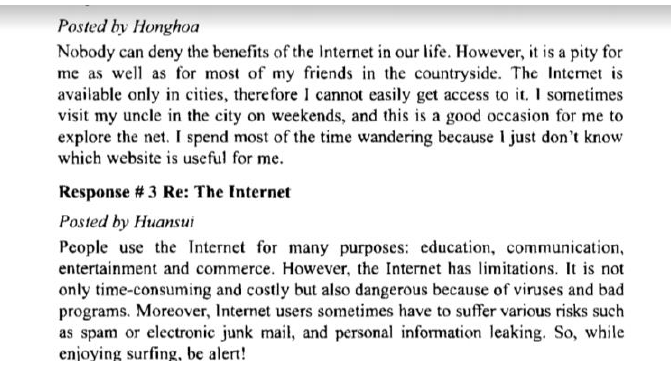
Figure 4. A sample of peer feedback on a topic chosen by a group